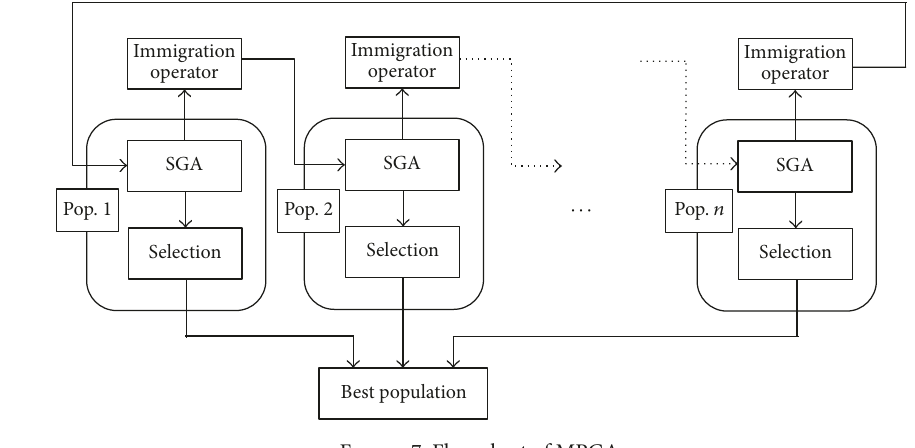
Figure 7: Flow chart of MPGA.